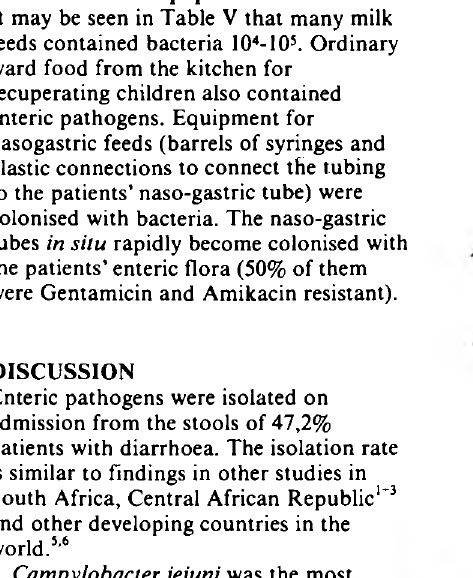
TABLE 4 Pathogens Cultured from Environment